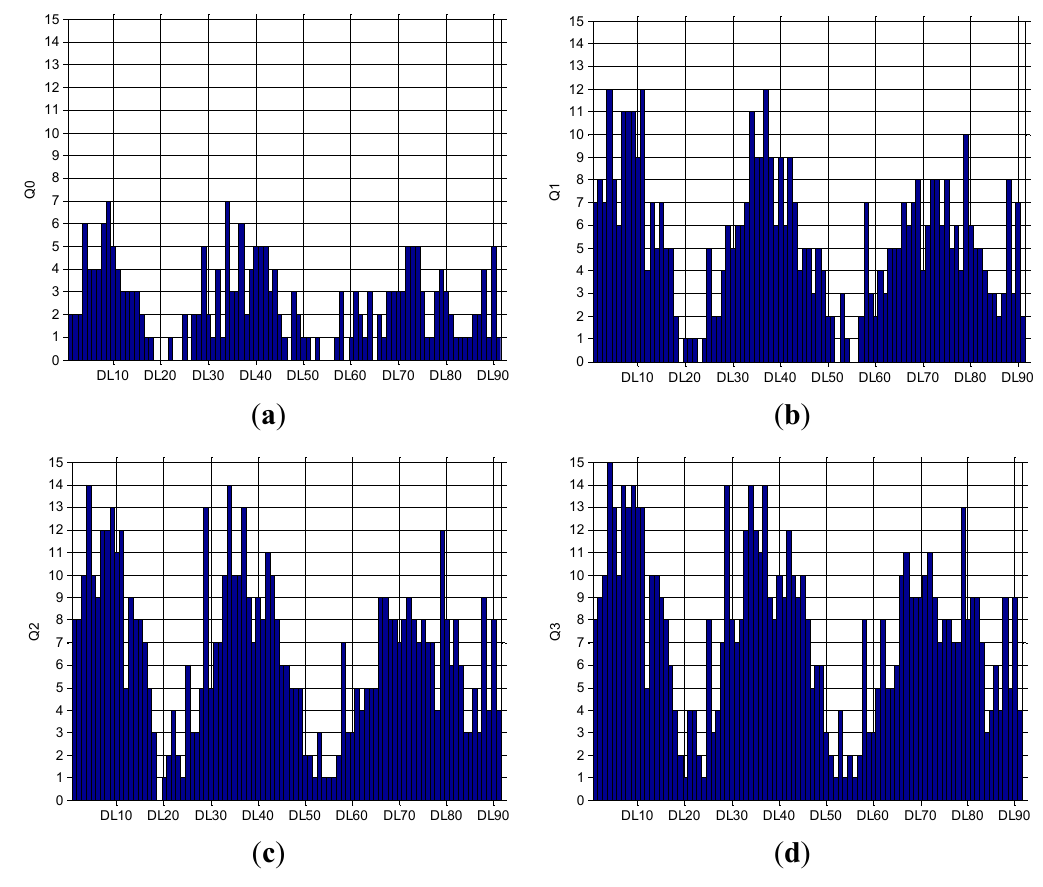
Figure 7. Bar plots of the lead quality ( a ) Q0, ( b ) Q1, ( c ) Q2 and ( d ) Q3 for all DLs.